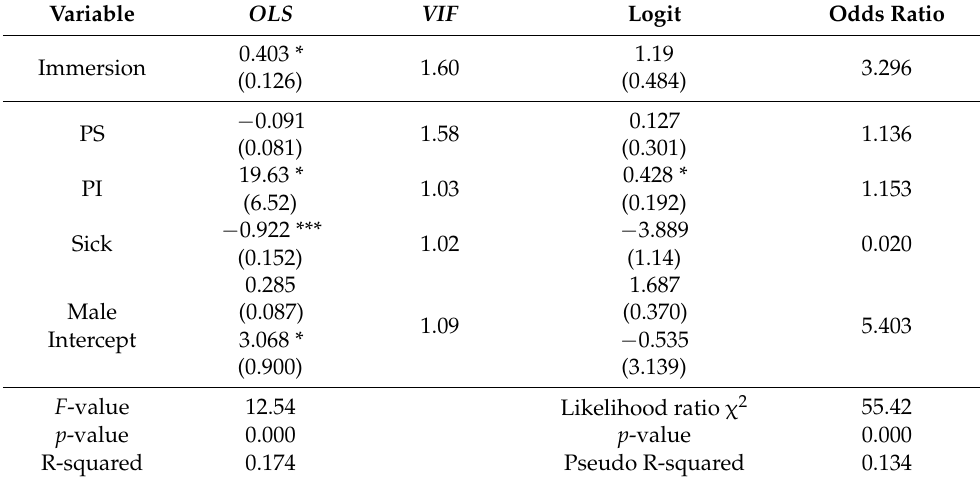
Table 1. OLS estimation showed that Immersion and peak Immersion have positive effects on Mood. When predicting high and low Mood using a logit estimation, only peak Immersion was significant. Sick and Male are controls. Standard errors are in parenthesis and * = p < 0.05, ** = p < 0.01, *** = p <